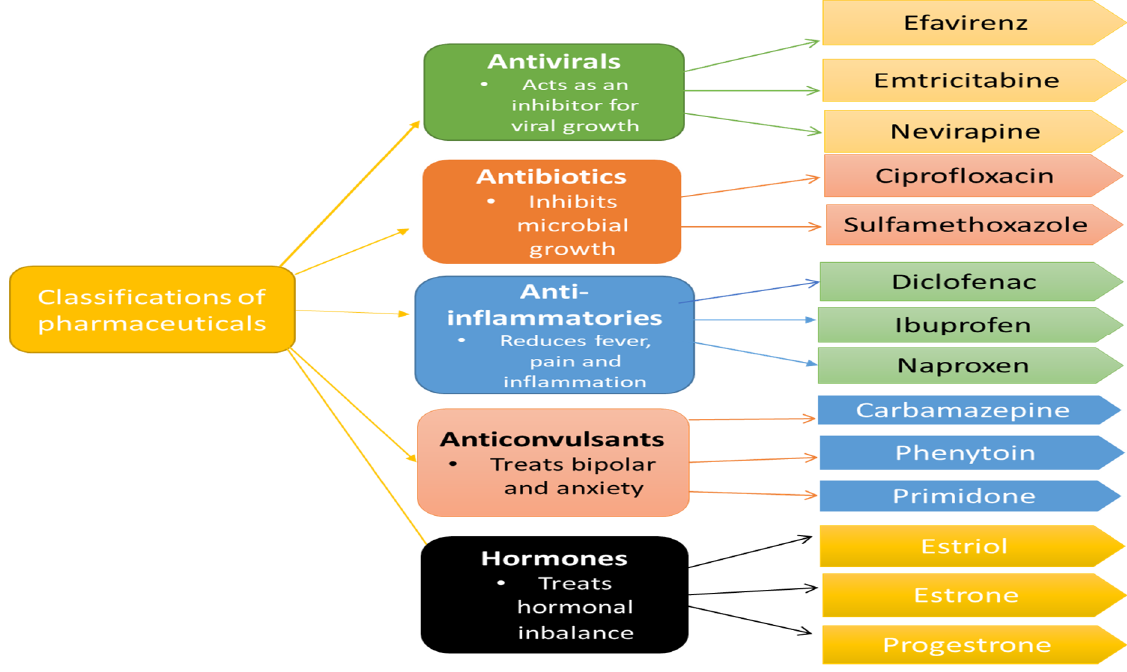
Figure 1. Classifications of common pharmaceutical pollutants in wastewater.